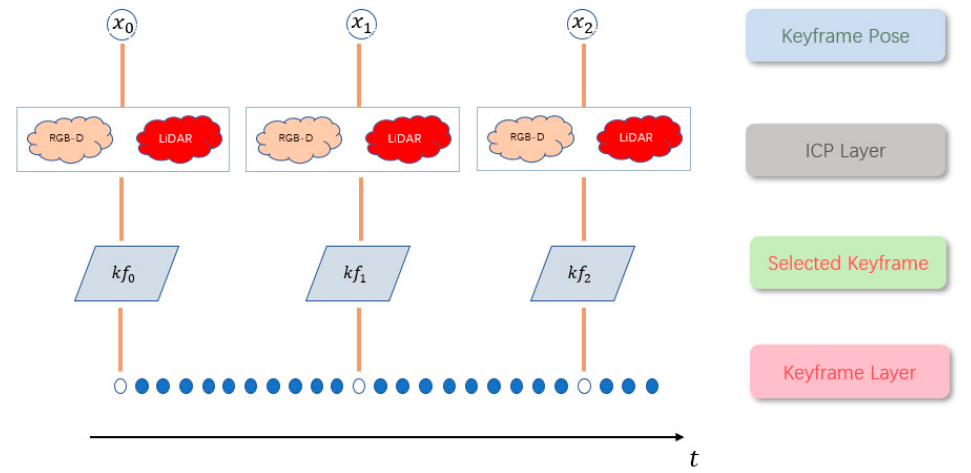
Figure 7. Process of accurate pose determination from LiDAR data.